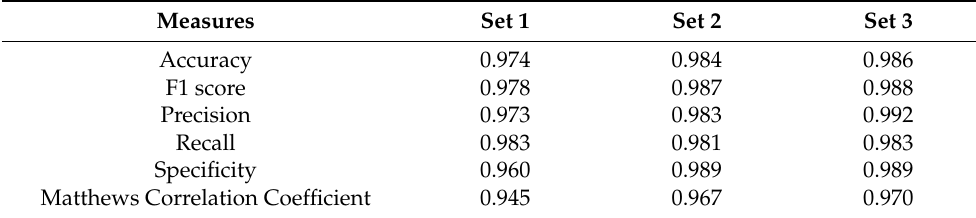
Table 4. Effectivity of models learned by SVM with GKRBF on three various sets—Set 1, Set 2 and Set 3 of attributes from Table 2.